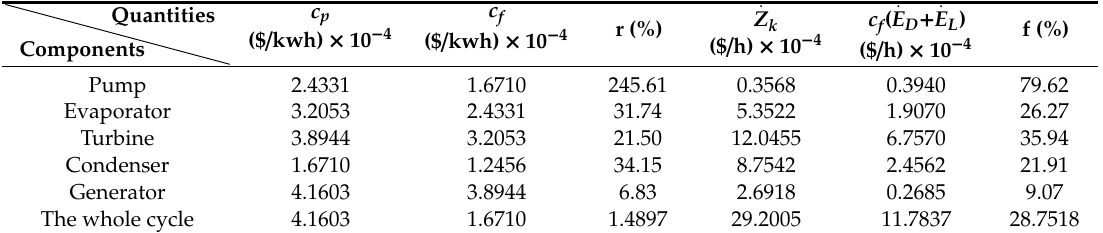
Figure 9. The Pareto frontier solutions for model 3 with Pentane [0.6] / R24fa [0.4]. Table 7. The components’ exergo-economic specifications of the best possible